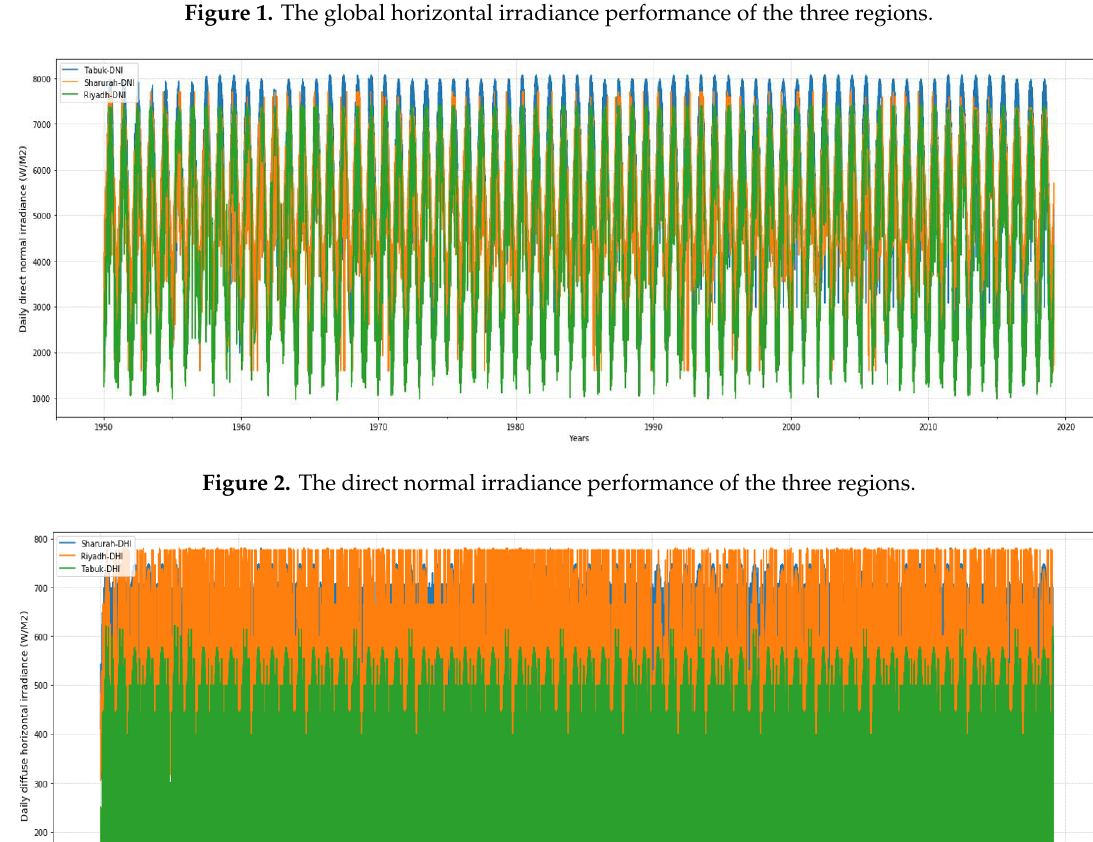
Figure 1. The global horizontal irradiance performance of the three regions.